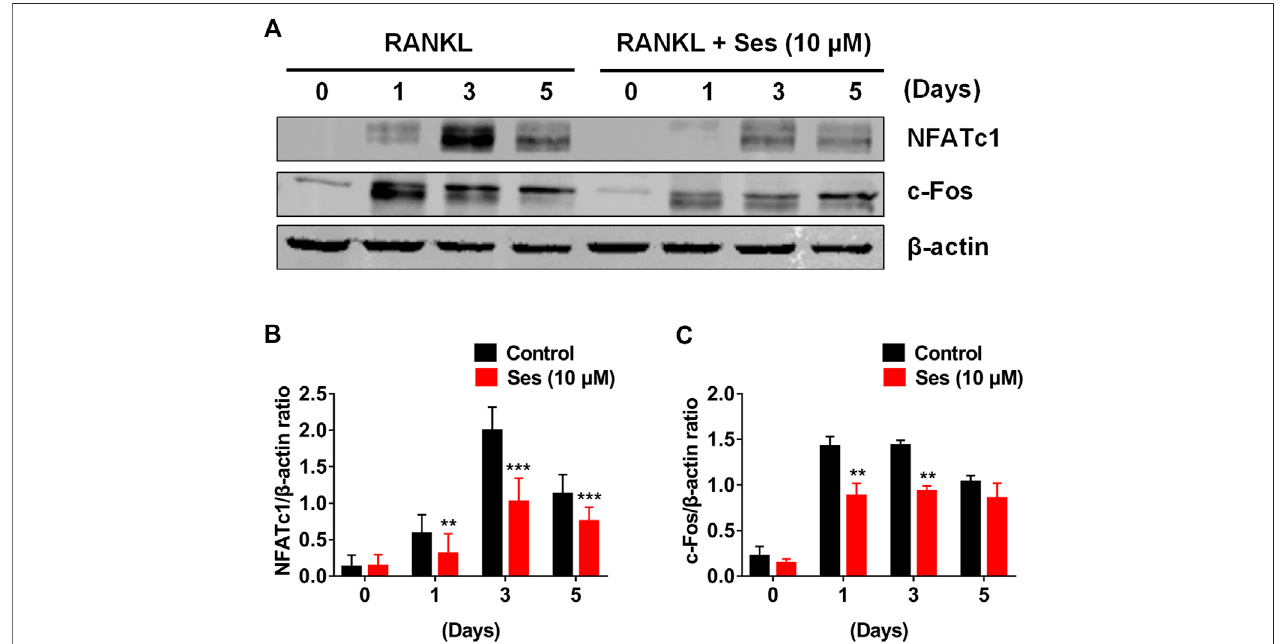
FIGURE 6 | Ses inhibits osteoclast differentiation by inhibiting the expression of c-Fos and NFATc1induced by RANKL. (A) Representative Westernblotting of the effectofSesontheexpressionofc-FosandNFATc1duringosteoclastformation.Withorwithout10 μ MSestreatment,RANKLwasusedtostimulateBMMsfor0,1,3, and 5 days. (B,C) Quantitative ratio ofNFATc1and c-Fos tothe band strength of β -actin ( n (cid:1) 3). The above data are expressed asthe mean ± SD; * p < 0.05, ** p < 0.01, and *** p < 0.001. Ses, sesamolin; RANKL, receptor activator of nuclear factor- κ B ligand; NFATc1, nuclear factor of activated T cells 1; c-Fos, proto-oncogene C-Fos.